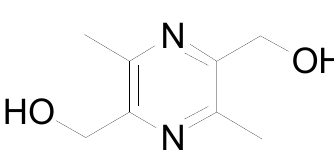
Figure 1. Structure of LZDO